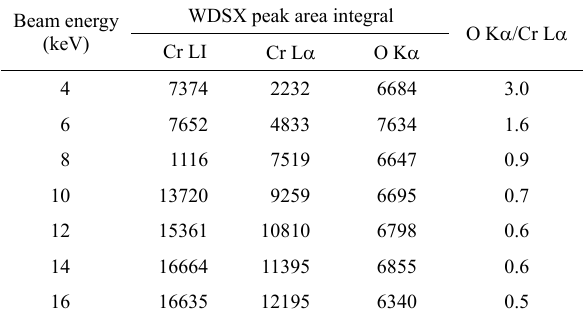
Fig. 4 WDSX spectrum of sample 1 annealed at 700 ℃ (sample 1a). Table 1 Peak area and O:Cr relative content in the annealed sample at different electron beam energies